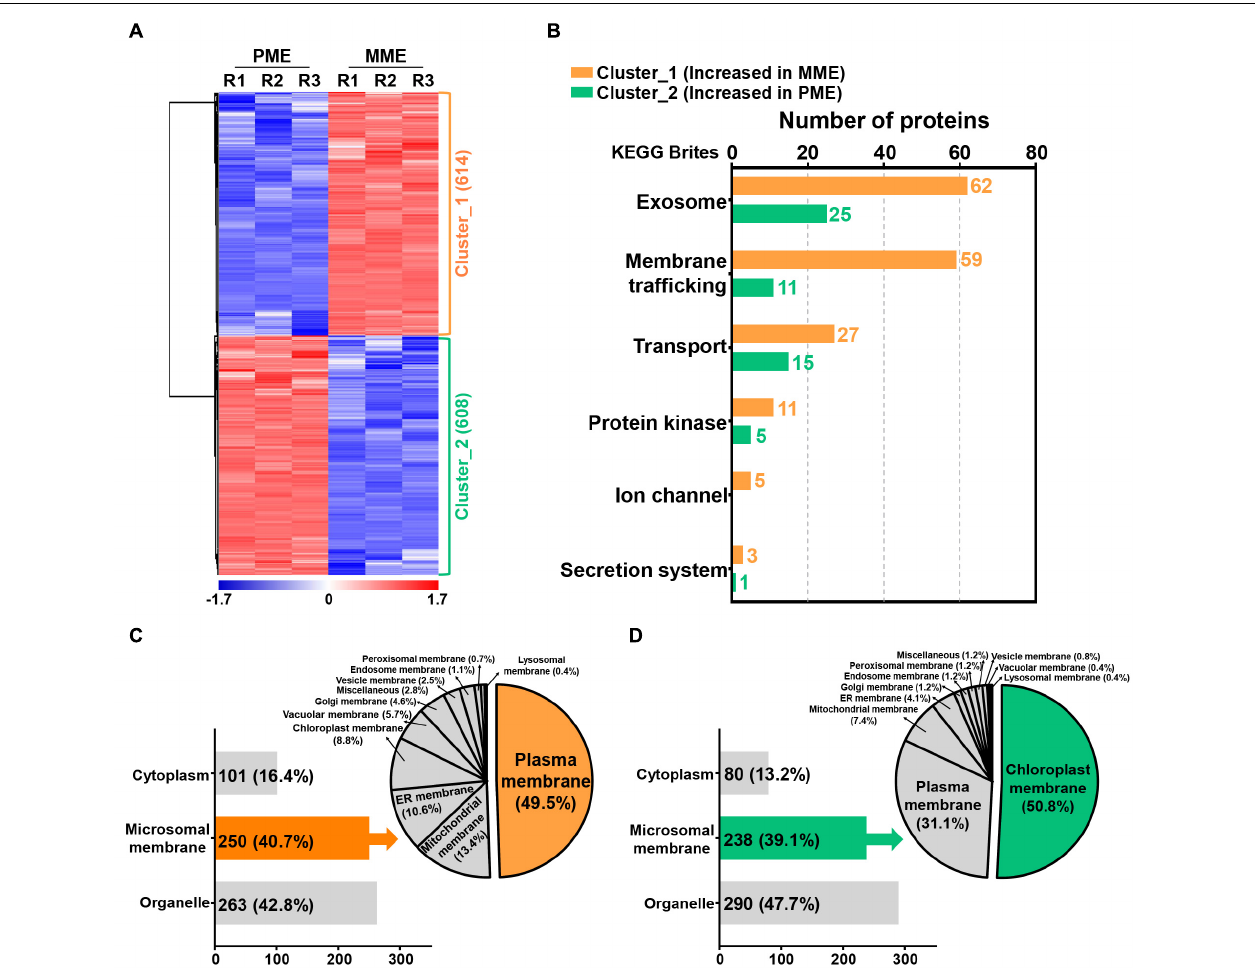
FIGURE 2 | Quantification and functional characterization of the significantly modulated microsomal membrane proteins of rice leaves. (A) Hydrophobic cluster analysis (HCA) of 1,222 significantly modulated proteins grouped into two major clusters based on their abundance patterns. (B) Functional hierarchical classification of proteins with increased abundance in the MME and PME samples, respectively, using the List of identified Kyoto Encyclopedia of Genes and Genomes (KEGG) brite database. Subcellular localization analysis of significantly modulated proteins is represented as clusters, wherein cluster_1 corresponds to the increased abundance in MME (C) and cluster_2 corresponds to the increased abundance in PME (D)